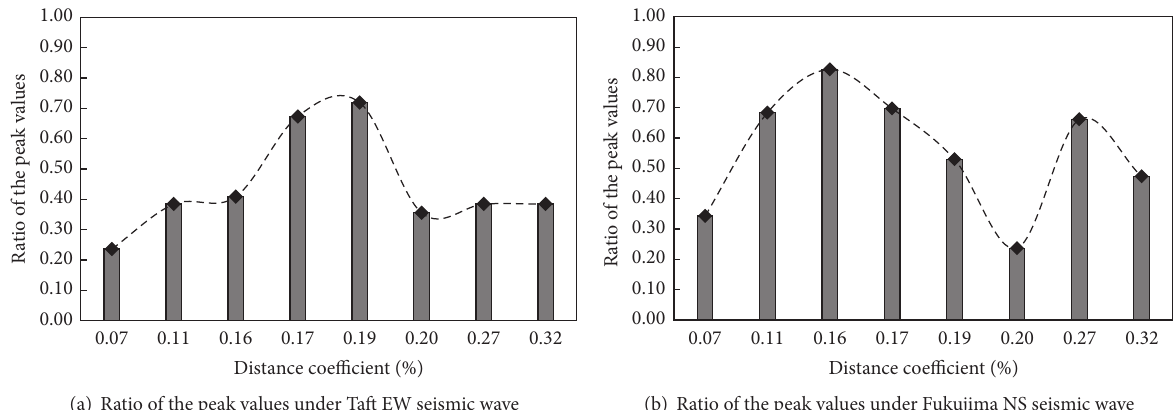
Figure 7: Ratios of the peak values for the offshore platform with and without bufferable TMD for different distance coefficients under (a) the Taft EW seismic waves and (b) the Fukujima NS.